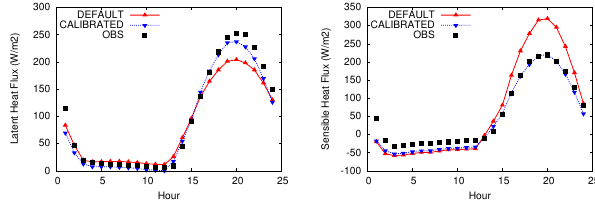
Fig. 3. Comparison of average diurnal cycles of latent (left column) and sensible heat (right column) fluxes from the uncoupled Noah (version 3.2) LSM simulations using the default model parameters (DEFAULT) and calibrated parameters (CALIBRATED) against the in-situ measurements (OBS) from 19 ARM-SGP